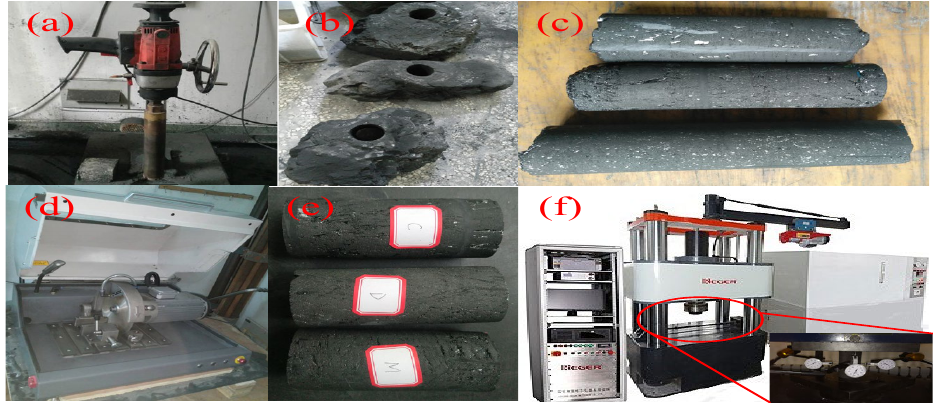
Figure 1. Coal sample preparation and mechanical test: ( a ) HZ–15 Electric Corer; ( b ) coal core block; ( c ) coal pillar; ( d ) TCHR–II Cutting Mill; ( e ) coal samples and ( f ) RE–8100SZ electro-hydraulic servo rock triaxial testing machine .